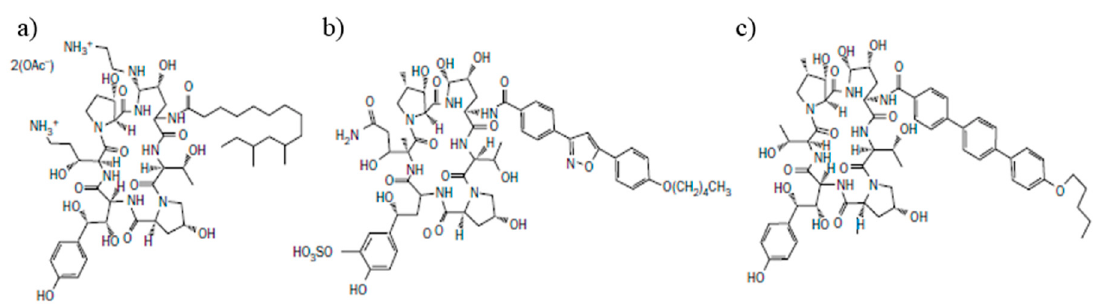
Figure 1. The chemical structure of ( a ) caspofungin, ( b ) micafungin, ( c ) anidulafungin.